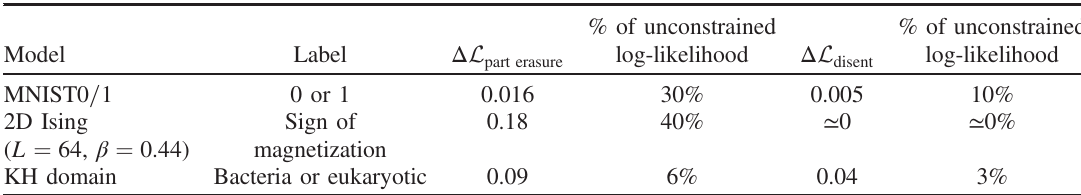
TABLE I. Decrease of log-likelihoods corresponding to partial erasure of the label with a fully constrained RBM Δ L , and to disentanglement with a partially constrained RBM Δ L part erasure expressed per data configuration and per pixel for MNIST 0 = 1 , per spin for 2D Ising, and per protein site for the KH domain.